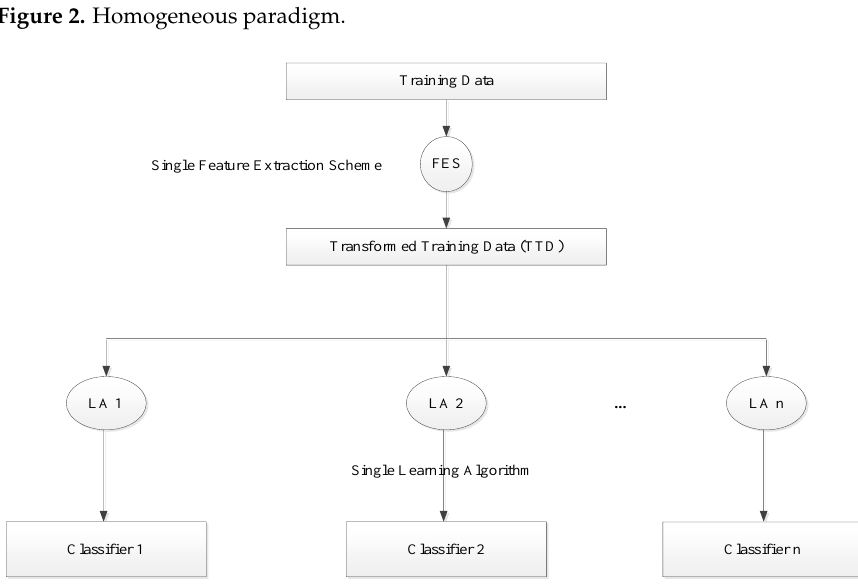
Figure 2. Homogeneous paradigm.